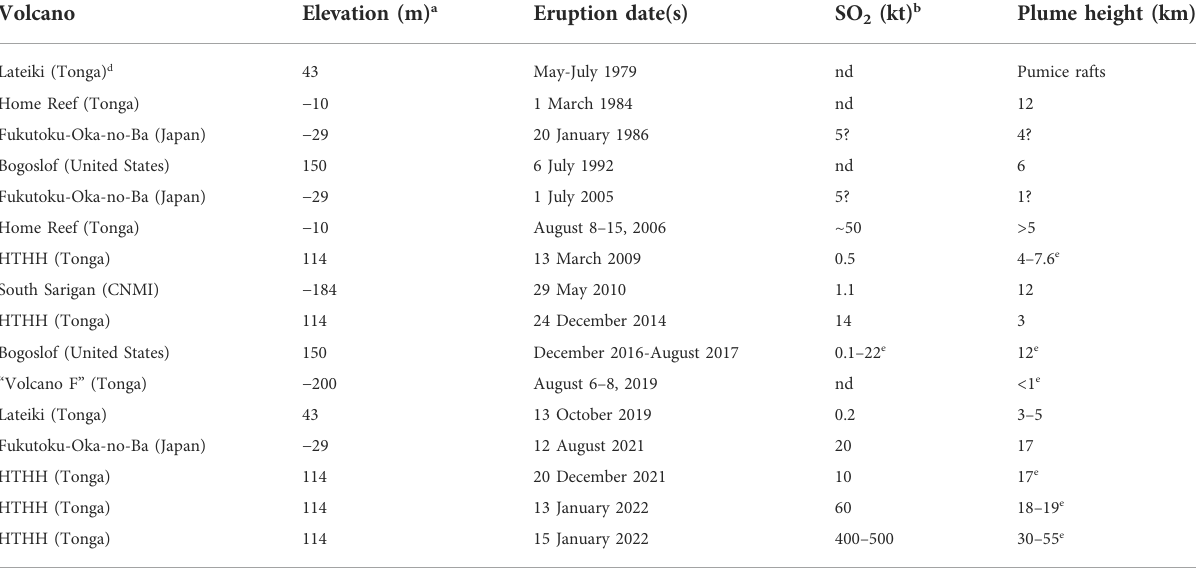
TABLE 4 Submarine volcanic eruptions in the satellite era (since 1978) with potential or con fi rmed subaerial plumes.